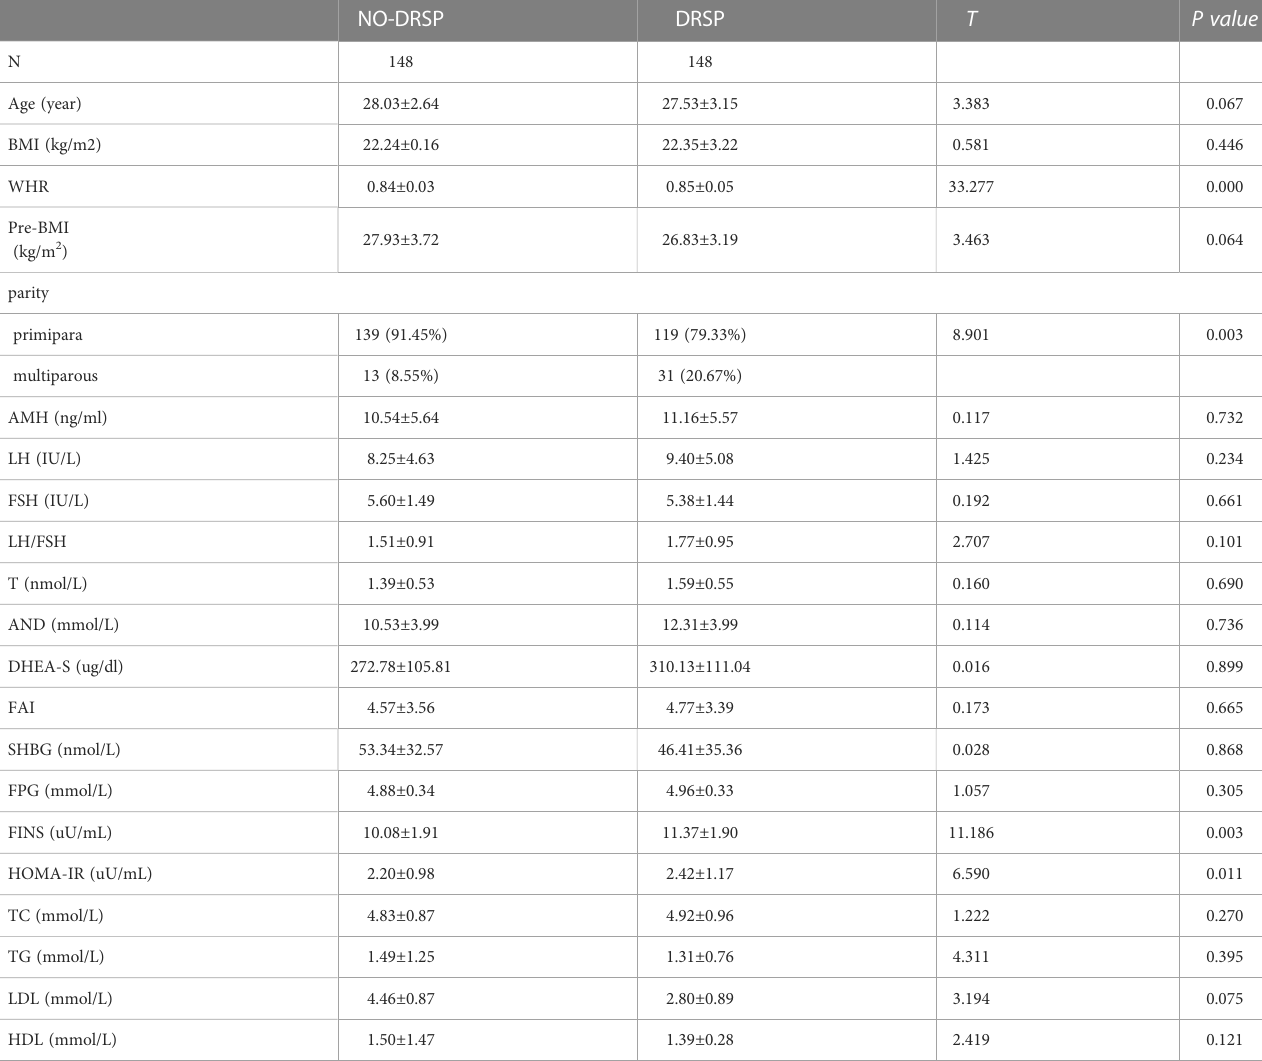
TABLE 1 Baseline Characteristics of